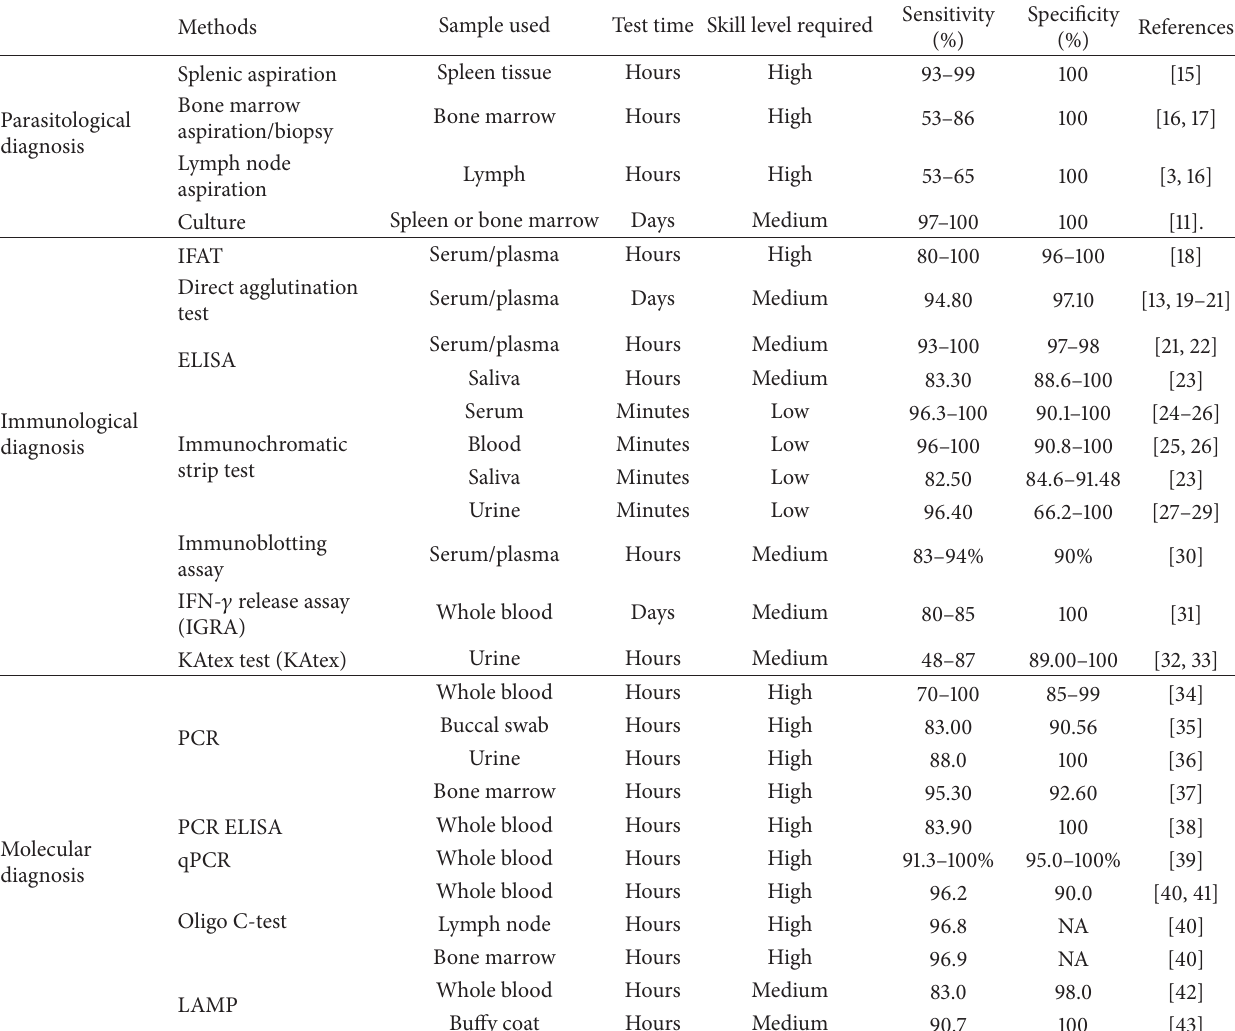
Table 1: Sensitivity and specificities of various tests in VL